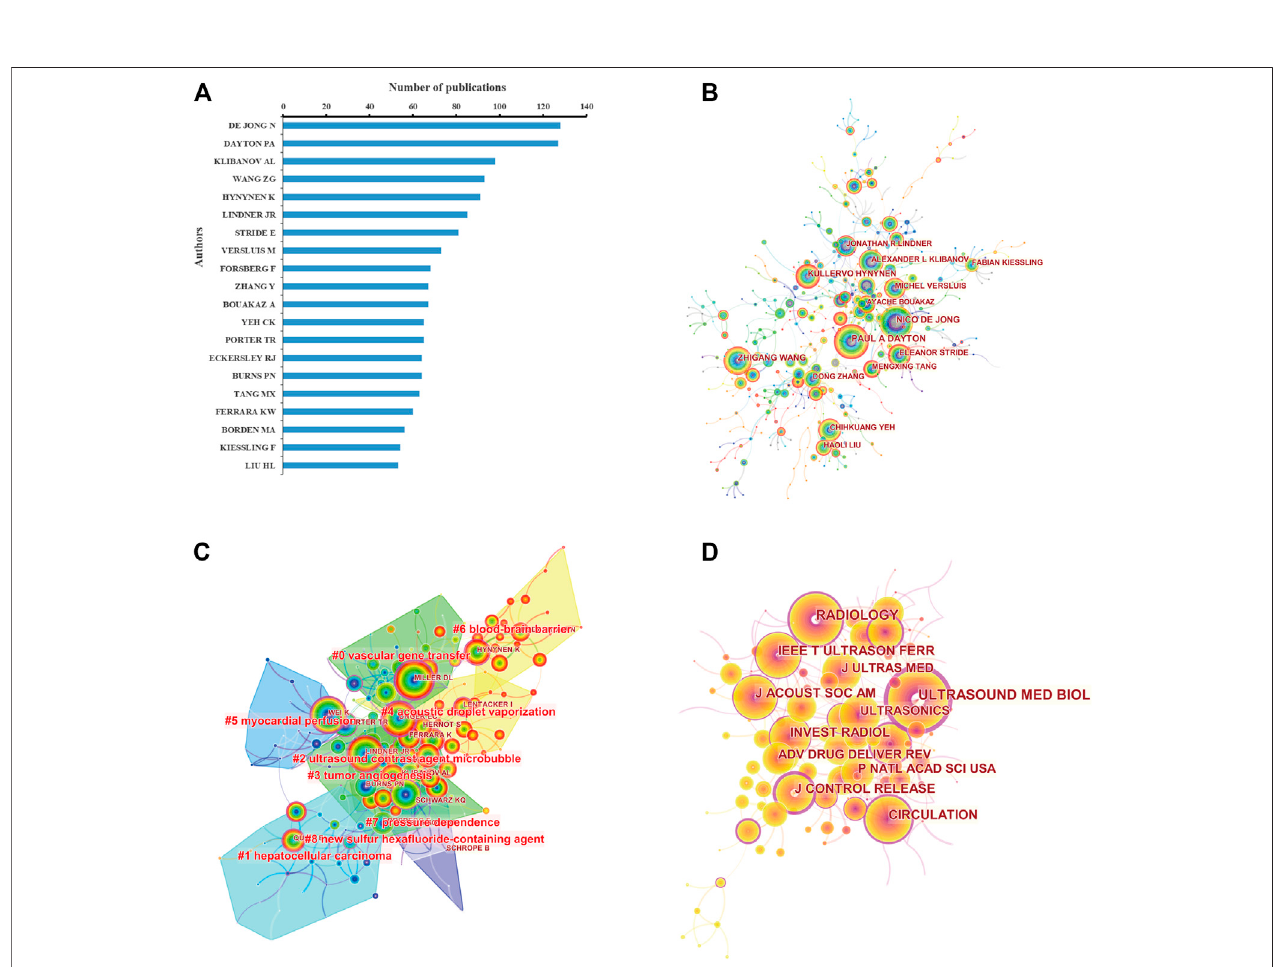
FIGURE 6 | (A) Top 20 most productive authors based on the number of publications. Coauthorship (B) and cocitation (C) analysis of authors involved in ultrasoundmicrobubbleresearchbasedonCiteSpace.Cited authors withsimilarcategories aregatheredinacluster.Alltheclustersarelabeled inred text,and thelinks between nodes representauthorscited together. (D) Cocitation analysis ofjournals. The sizeof thenodes represents the number of total cited timesofthe journals. The larger the node is, the more the cited times of the journal is. Nodes with purple outer rings are journals with high centrality (more than 0.1) in the network.